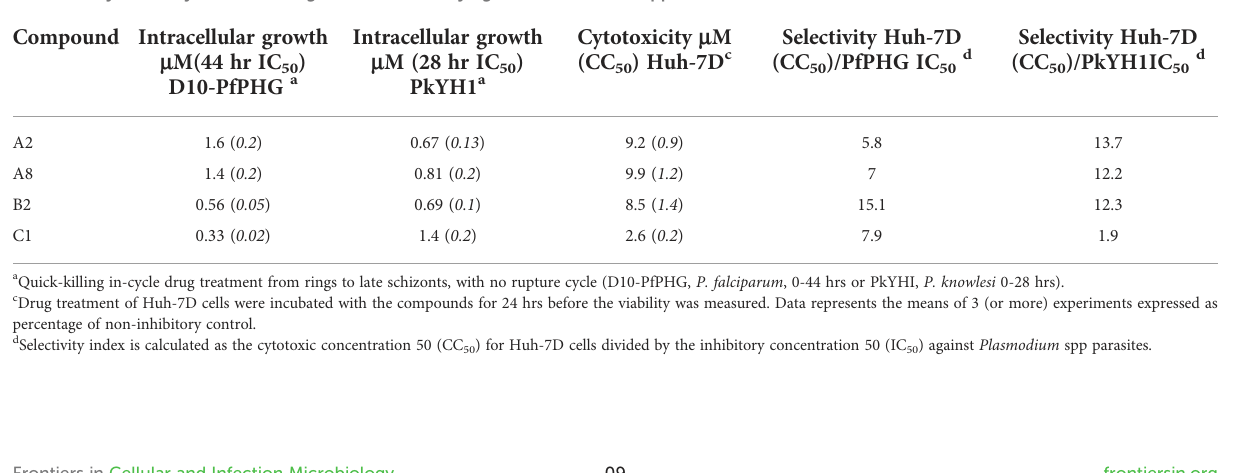
TABLE 2 Cytotoxicity of lead analogues and selectivity against Plasmodium spp.